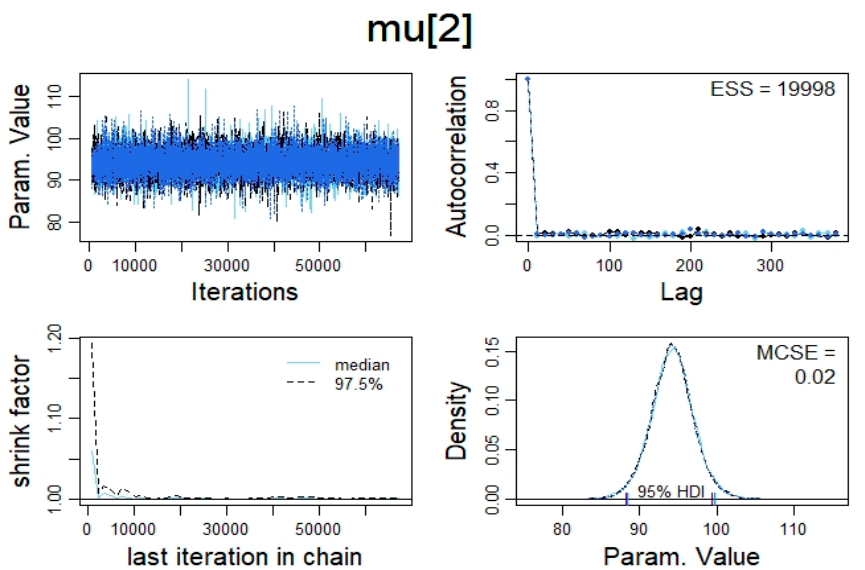
Figure 1. Example of representativeness and accuracy checks by examining the convergence of the Markov Chain Monte Carlo (MCMC) algorithm (the figure describes the convergence diagnostics for the variable MAP).